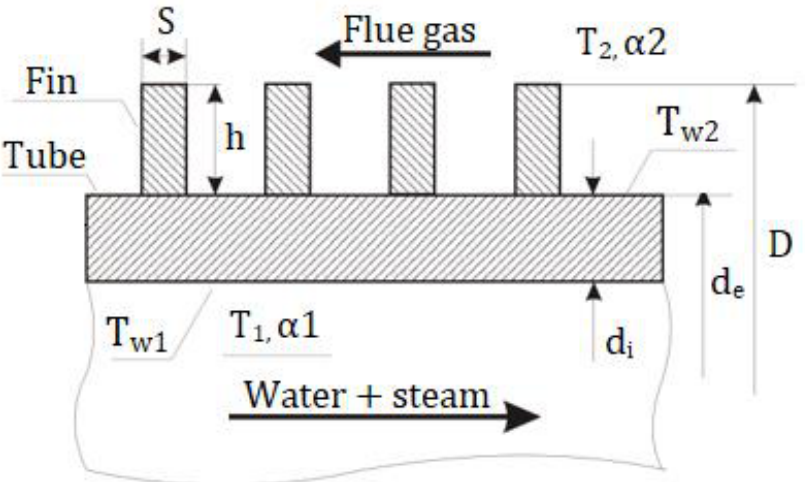
Figure 2. Diagram of heat exchange in a finned tube, where: T 1 — temperature of medium 1 (water, steam), α 1 — heat transfer coefficient in the medium-tube system, T W1 — barrier temperature on